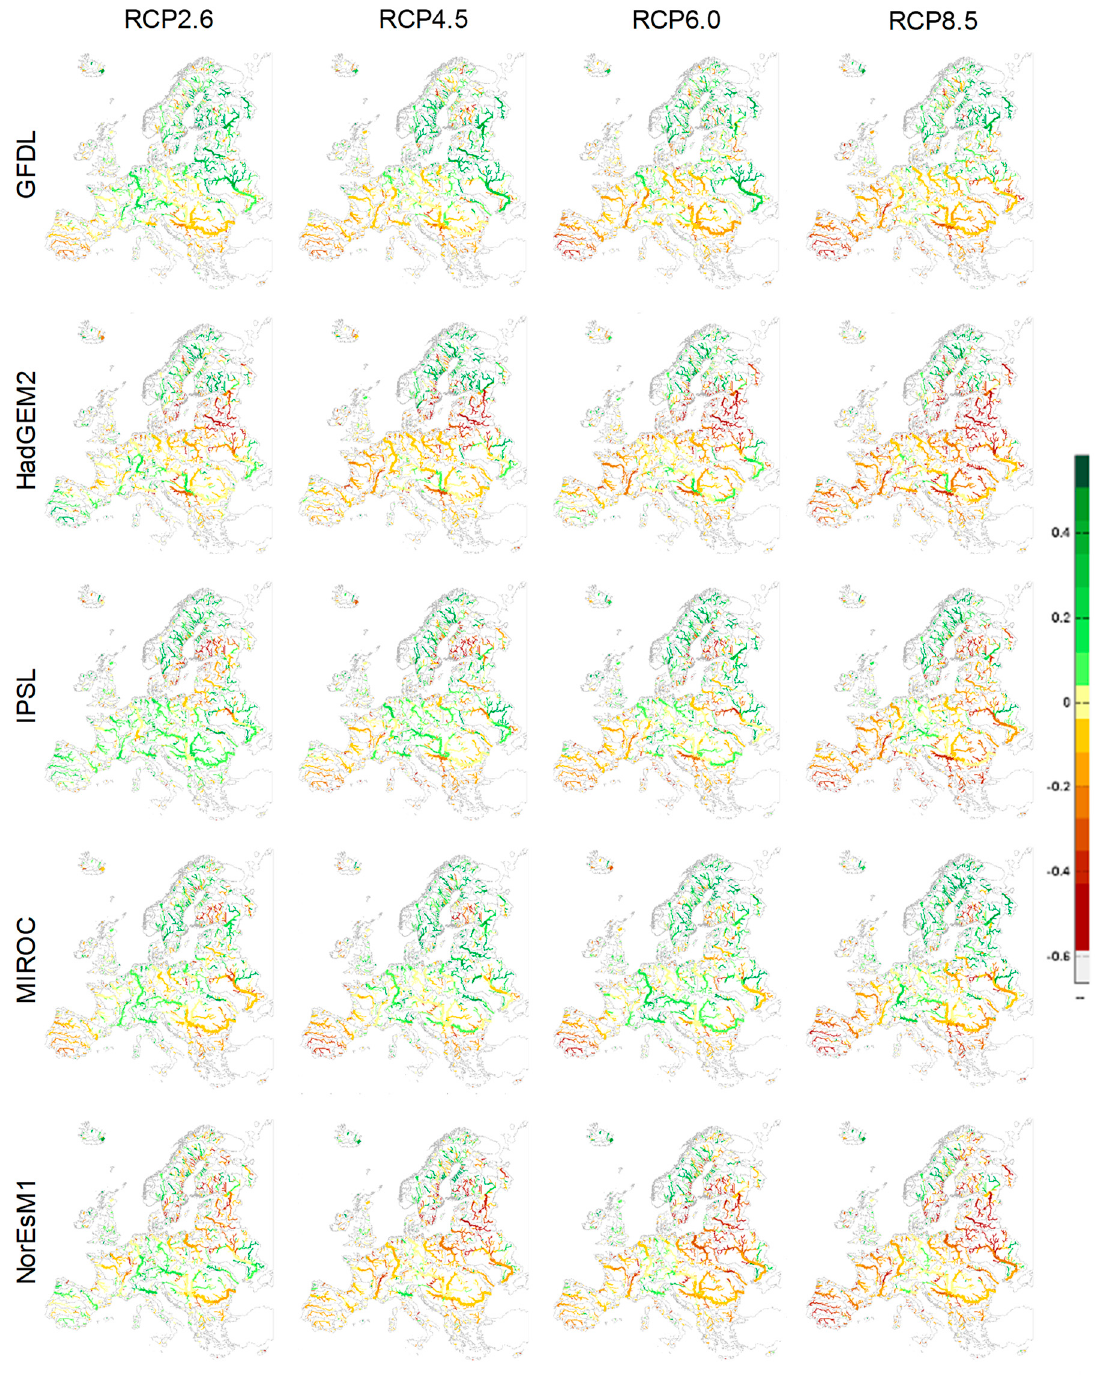
Figure 6. Changes in potential water availability for the long-term scenario (2060–2099) compared to the reference scenario (1960–1999), according to all climate models and emissions scenarios analysed. Red shading represents a decrease of the potential water availability and green shading an increase (individual maps at full resolution are available as supplementary files).